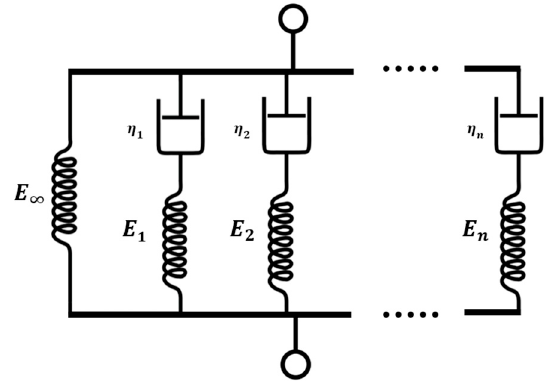
Figure 9. Generalized Maxwell model.